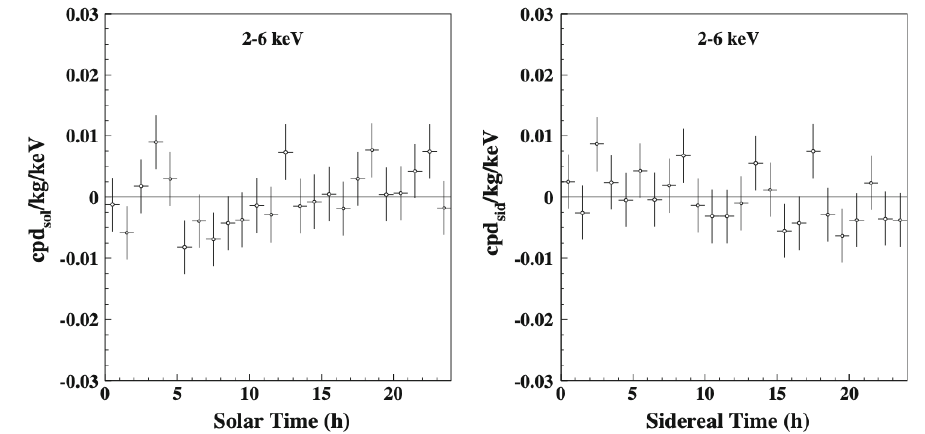
Figure 3. Experimental model–independent diurnal residual rate of the single-hit scintillation events, measured by the first four annual cycles of DAMA/LIBRA–phase1 (exposure of 1.04 tons × year) in the (2–6) keV energy interval as a function of the hour of the solar (left) and sidereal (right) day. The experimental points present the errors as vertical bars and the associated time bin width (1 h) as horizontal bars. Reprinted from Ref. [31] with Copyright Permission from The European Physical Journal